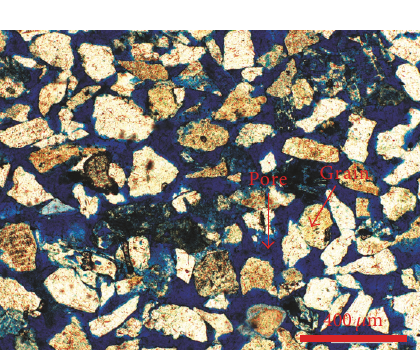
Figure 6: Simulation results of pore velocity field of Sample 2 ( 𝜇